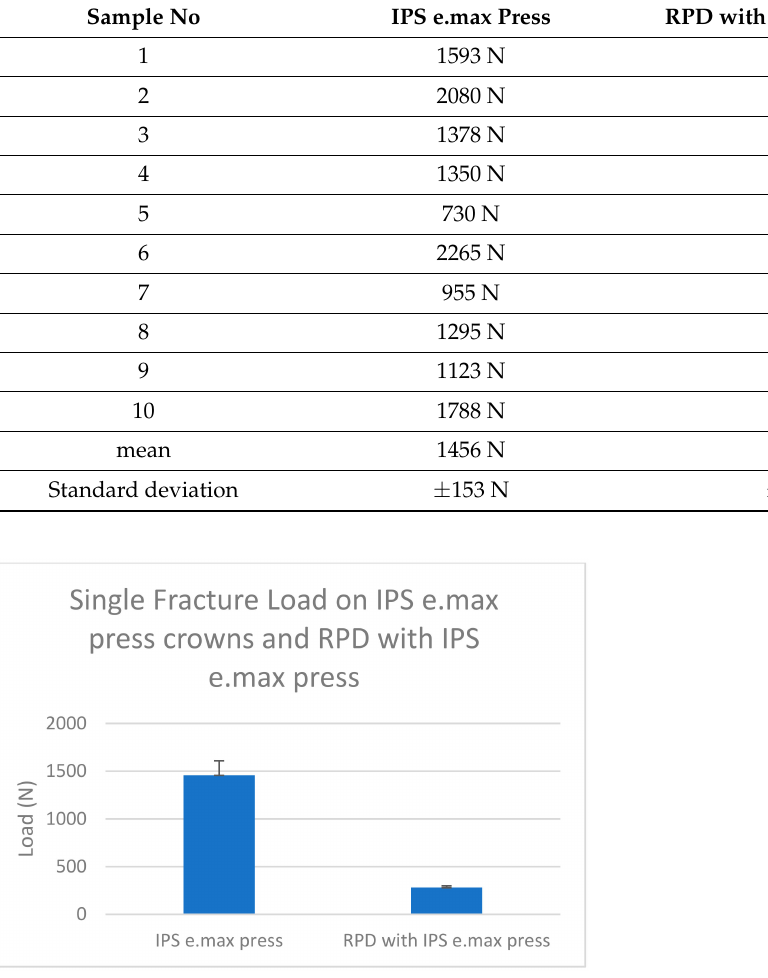
Figure 9. The mean fracture strength of IPS e.max Press crowns from the previous research [32] was significantly higher than that of RPD saddles with IPS e.max Press crowns in this study ( p ≤